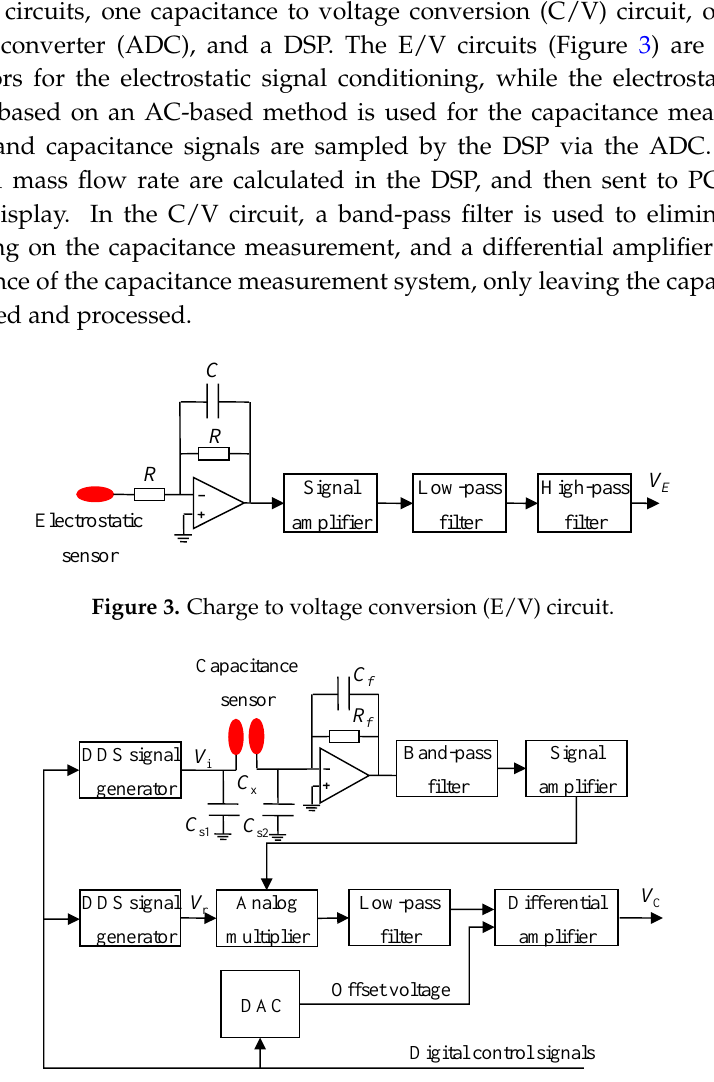
Figure 4. Capacitance to voltage conversion (C/V) circuit.